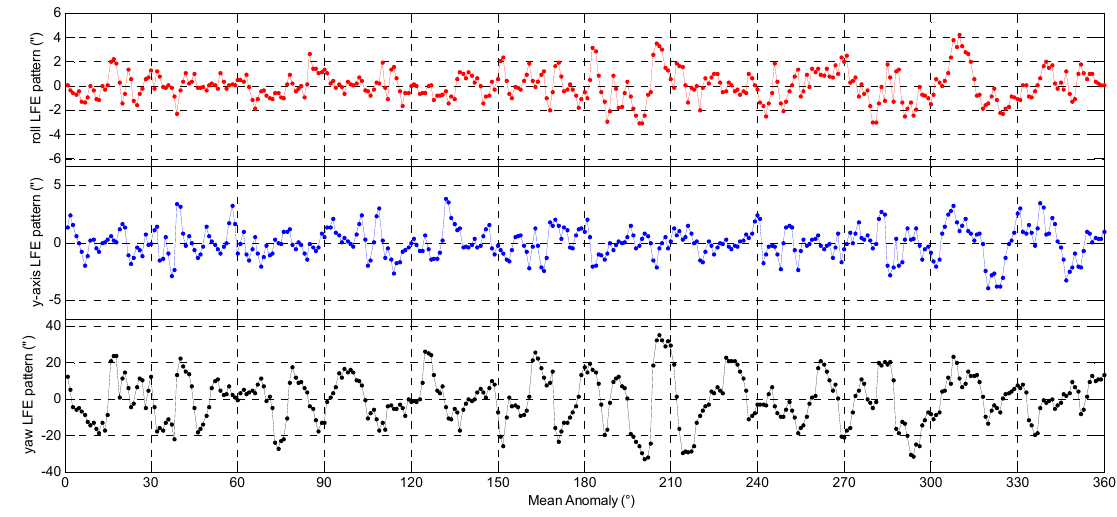
Figure 9. The low frequency errors pattern of the APS01 star tracker.